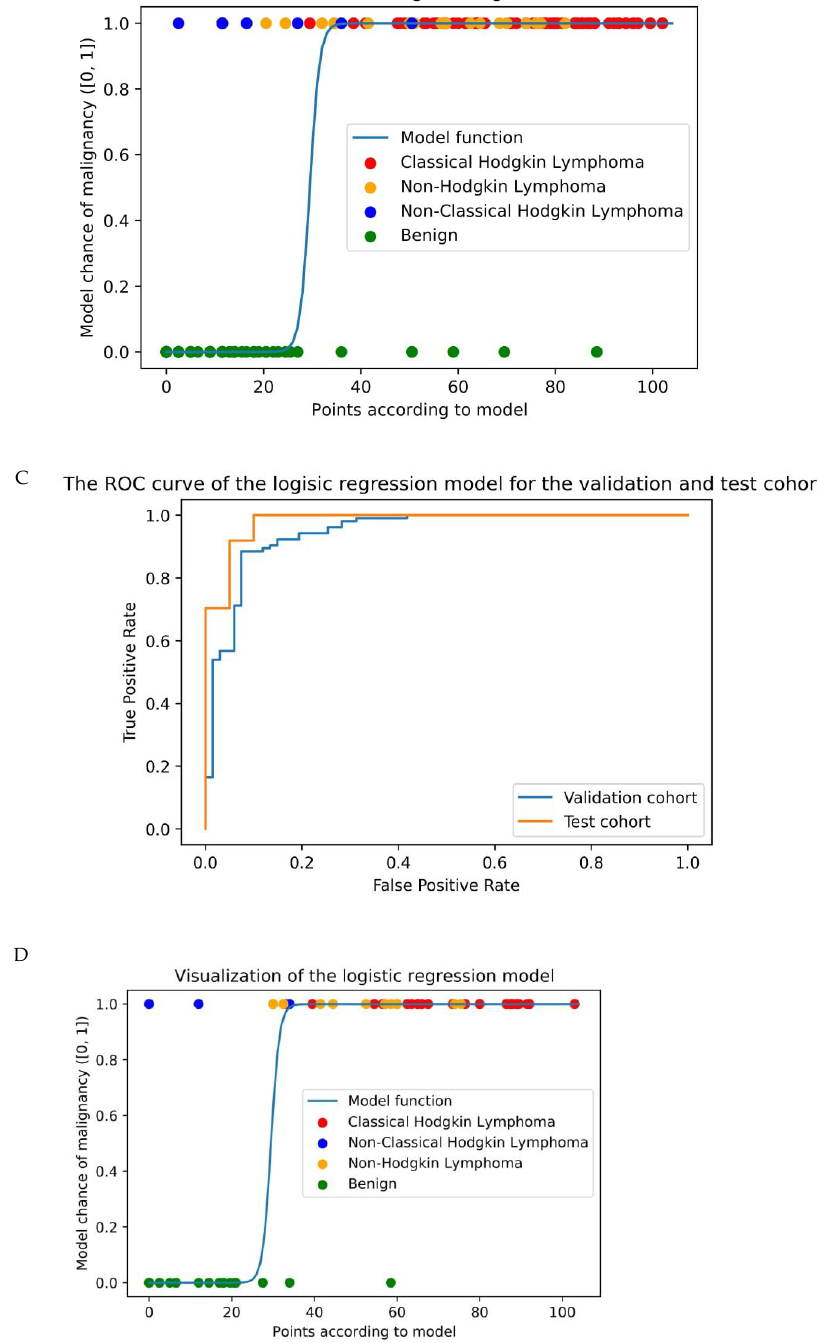
Figure 4. ROC curve and logistic regression curve scored by the diagnostic model in the study population (A) ( n = 171) and the test group (B) ( n = 57). ( A ) ROC curve of the study group, with an AUC of 92% (95% CI 87–96%); ( B ) the blue line represents the model function. With a cut-off point of 27.5, the figure demonstrates that all cHL and 22 out of 24 NHL were detected with this diagnostic model and 61 out of 67 patients with a benign cause were diagnosed as benign according to the model; ( C ) ROC curve of the study group and test group together. The test group had a comparable AUC of 98% (95% CI 95–100%); ( D ) with a cut-off point at 27.5, the figure demonstrates that 55 out of 57 patients were diagnosed correctly. All 37 patients with cHL and NHL were diagnosed correctly, and 18 out 20 patients with a benign cause were diagnosed as benign according to the